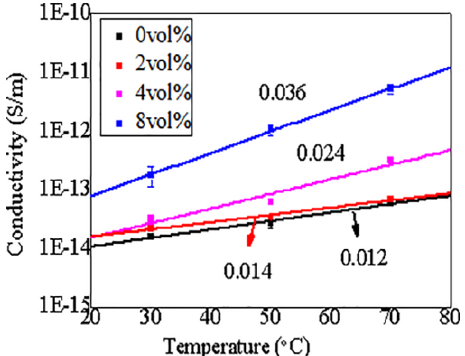
Figure 7. Relationship between conductivity and temperature characteristics of CCTO/EEPDM at 20 kV/mm.